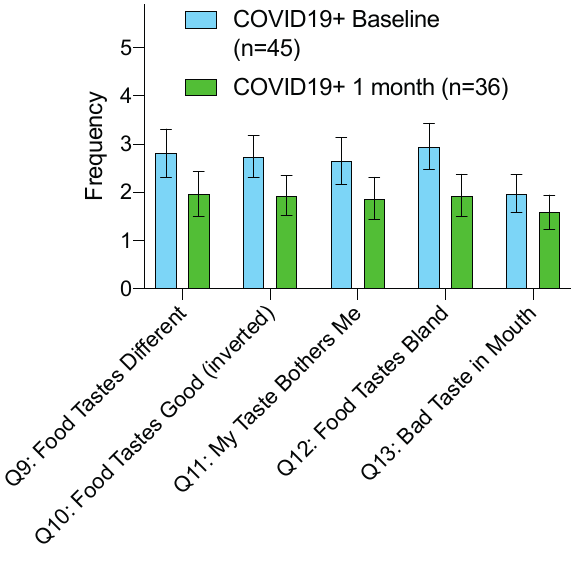
Figure S6. COVID-19 + Patients Reported Improved Gustatory Function at 1 Month Compared to Baseline. There was a significant difference in self-reported taste symptoms between COVID-19 + patients at baseline (blue) compared to 1 month later (green) in all categories except Q13: I have a bad taste in my mouth. Error bars represent 95% confidence intervals. Questions are answered on a 5-point Likert scale (1=never, 2=rarely, 3=sometimes, 4=often, 5=always). Q9: Food tastes different than I remember. Q10: Food has tasted good. Q11. My sense of taste has bothered me. Q12: Food has tasted bland. I have a bad taste in my mouth. Question 10 was inverted for